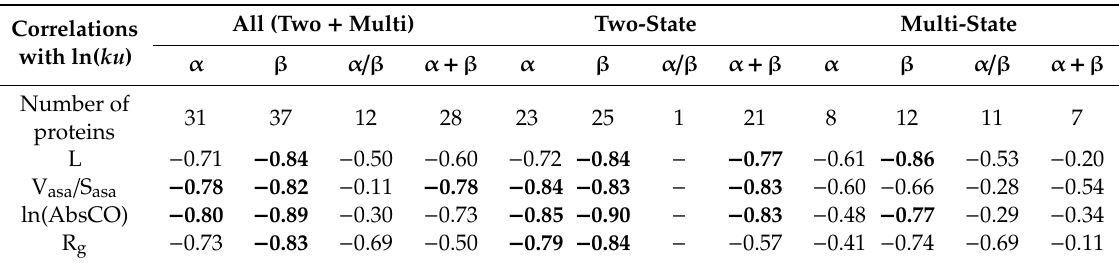
V asa / S asa , ln(AbsCO) and R g ) for four structural classes of proteins ( α , β , α / β and α + β ). Table 4. Correlations between the logarithm of the unfolding rate (ln( ku ) and structural parameters All (Two + Multi) (L, V asa /S asa , ln(AbsCO), and R g ) for four structural classes of proteins ( α , β , α / β , and α + β ). Correlations with ln( ku ) Correlations with